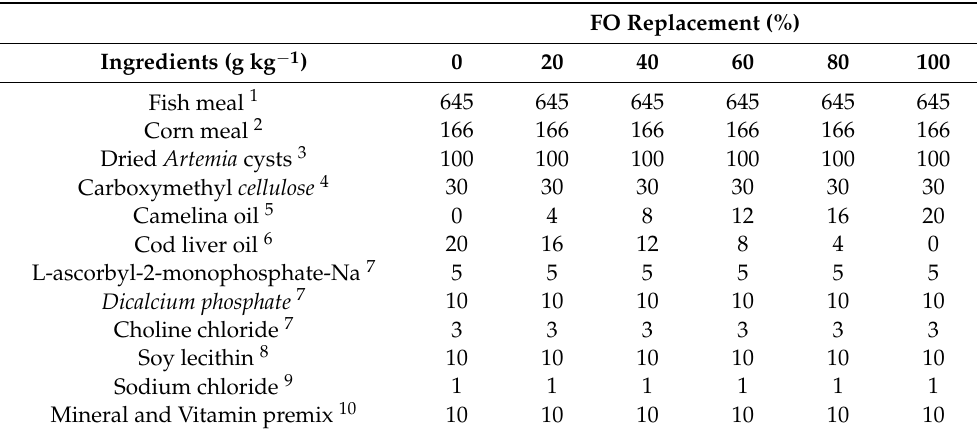
Table 1. Formulation of the practical diets (g kg − 1 diet, wet basis) with different replacements of cod liver oil (FO) with camelina